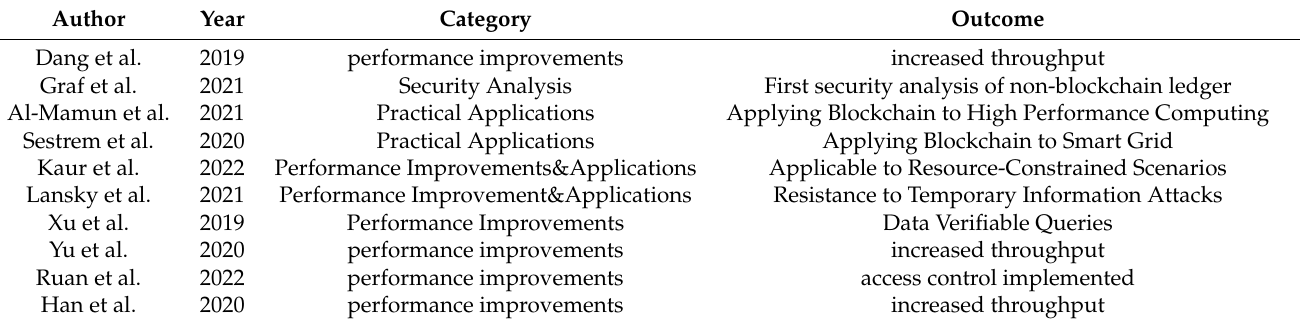
Table 2. Blockchain technology